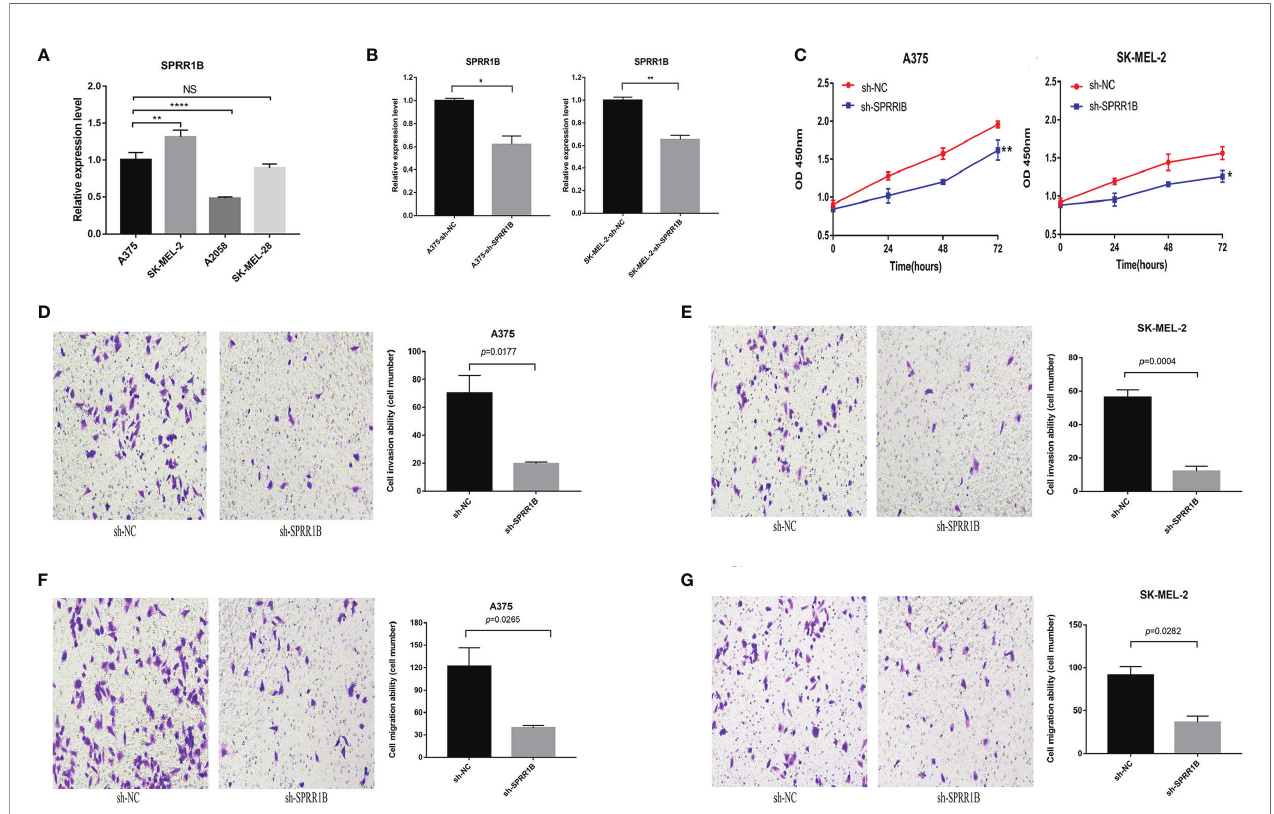
FIGURE 12 | (A) the relative expression of SPRR1B gene in four melanoma cell lines, where *P < 0.05; **P < 0.01; ****P < 0.0001; NS, not statistically signi fi cant; (B) the expression of SPRR1B gene in knock-down group and contrast group in a375 cell line and SK-MEL-2 cell line; (C) CCK8 proliferation experiment results of C)A375 cell line and SK-MEL-2 cell line; (D) A375 cell knockdown SPRR1B genome and sh-NC group cell invasion experiment results (200 times fi eld of vision) and statistical results; (E) SK-MEL-2 cell knockdown SPRR1B genome and sh-NC group cell invasion experiment results and statistical results; (F) The experimental results and statistical results of A375 cell knockdown SPRR1B genome and sh-NC group cell migration; (G) experimental results of skmel-2 cells knocking down SPRR1B genome and sh-NC group cell